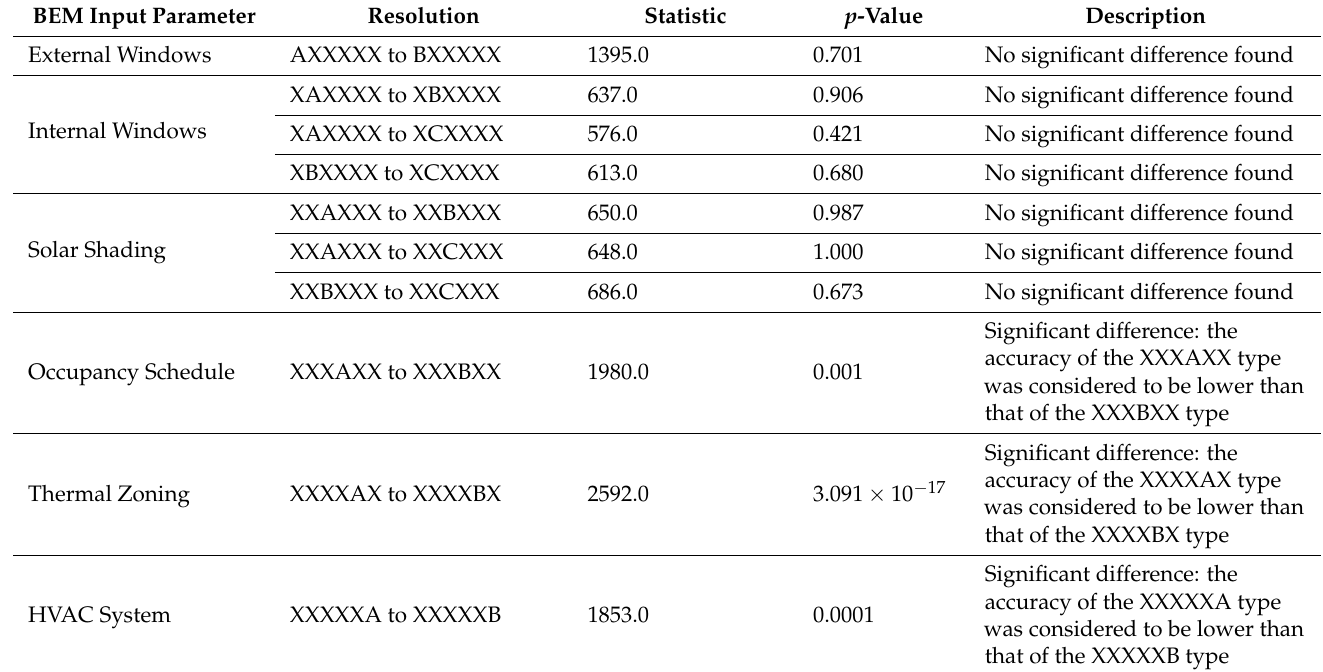
Table 6. The analysis of U-testing for the CVRMSE boxplot (zone mean air temperature).